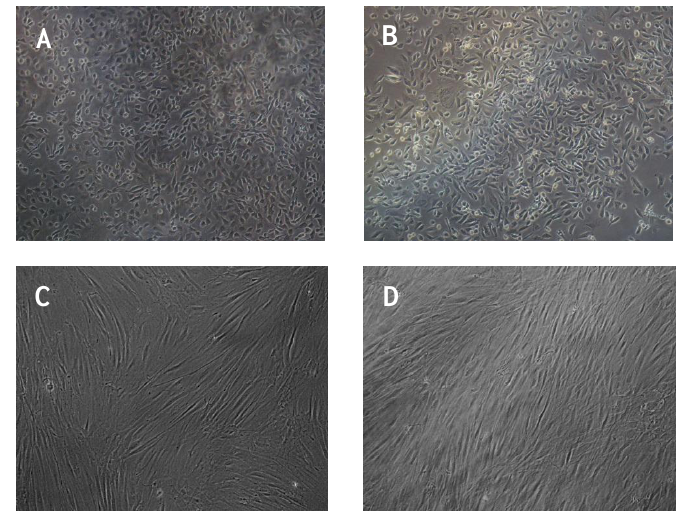
Figure 6. Microscope Images (10×) of: ( A ) osteoblasts on TCP; ( B ) osteoblasts on glass slides; ( C ) fibroblasts on TCP; and ( D ) fibroblasts on glass slide.